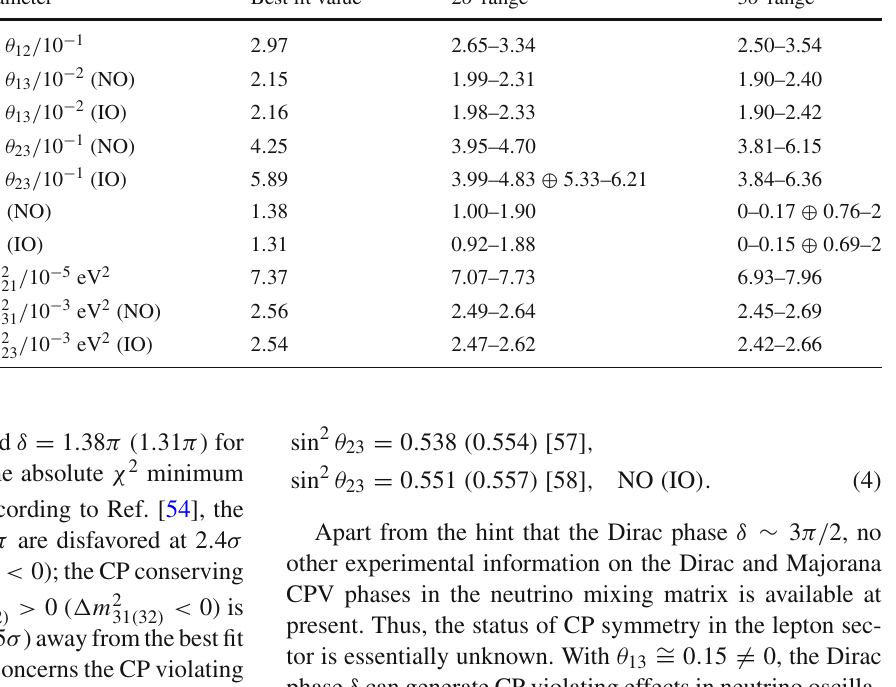
Table 1 The best fit values, 2 σ and 3 σ ranges of the neutrino oscillation parameters obtained in the global analysis of